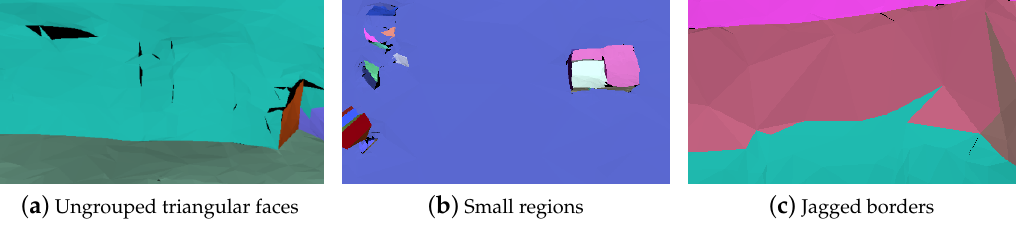
Figure 4. Examples of the common problems in the shape detection results. ( a ) Ungrouped triangular faces. ( b ) Small regions. ( c ) Jagged